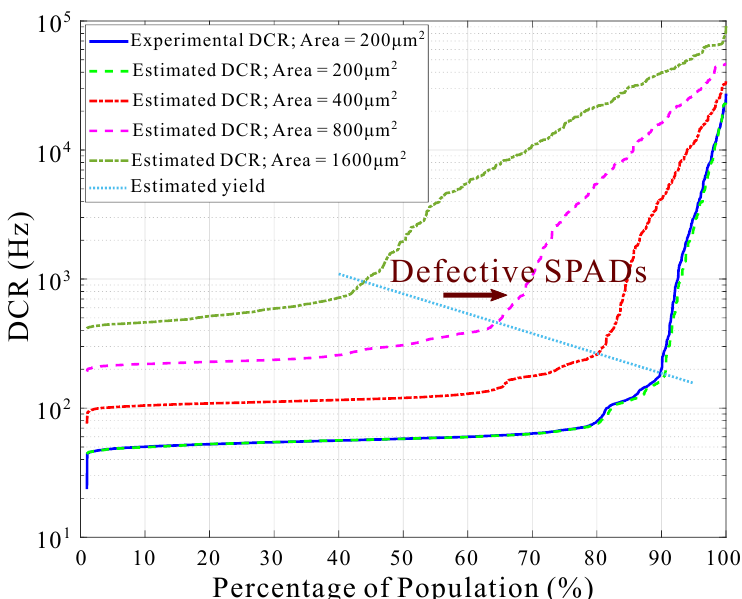
Figure 6. Experimental (solid blue) and estimated (dashed) DCR population distribution for n ∼ 2000 SPADs. Experimental data were obtained from a digital SiPM implemented in LFoundry 110nm CIS technology. The breakdown voltage is 18V, the excess voltage is 2V, and the dead time is